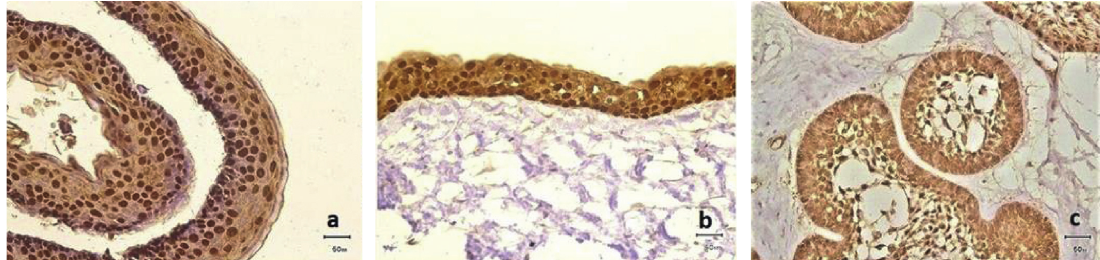
Figure 1: Immunohistochemical expression of maspin (a) in OKC epithelial lining, (b) in DC epithelial lining, and (c) in AB (original magnification × 400).